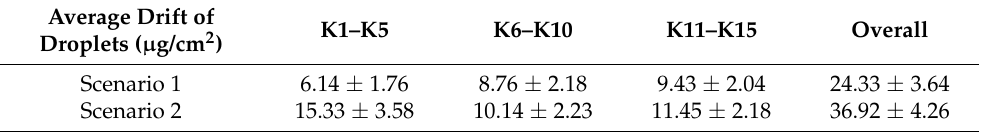
Table 3. Droplet drift under two application